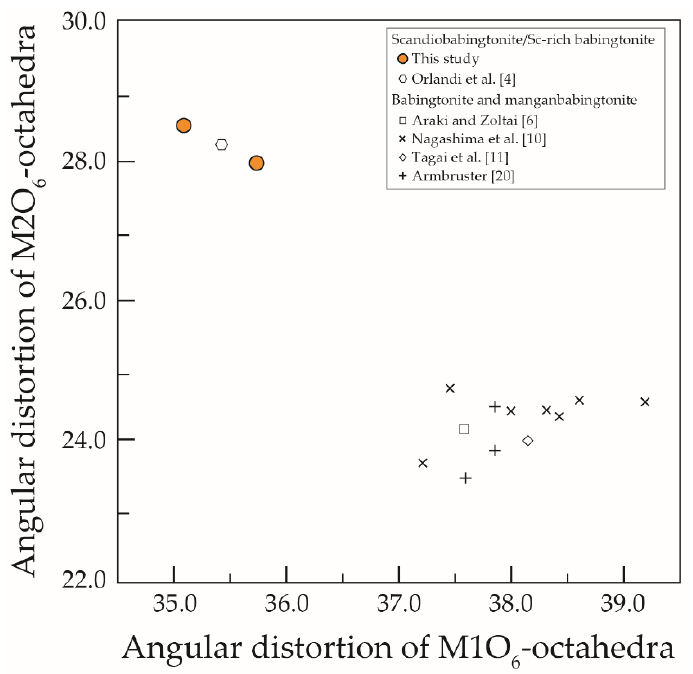
Figure 5. Relationship between angular distortion [25] between M1O 6 and M2O 6 . Definition of angular deformation was given in the footnote of Table 4. For our studied specimens, errors (3 σ ) are smaller than the symbol size [4,6,10,11,20].